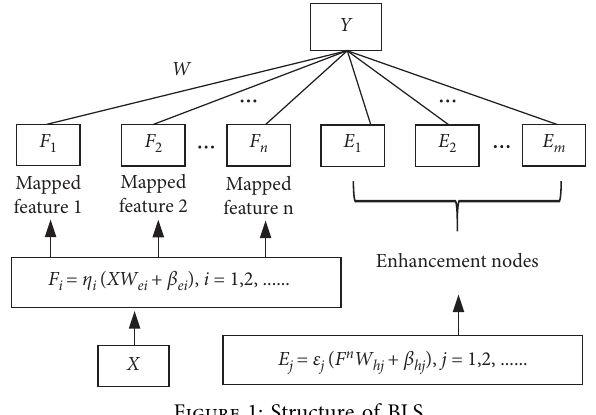
Figure 1: Structure of